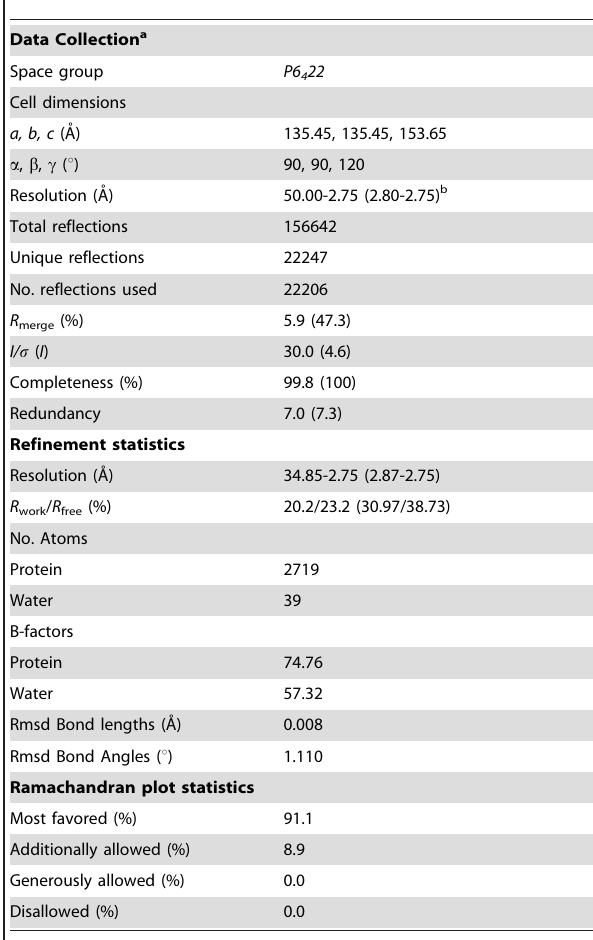
Table 1. Data collection and refinement